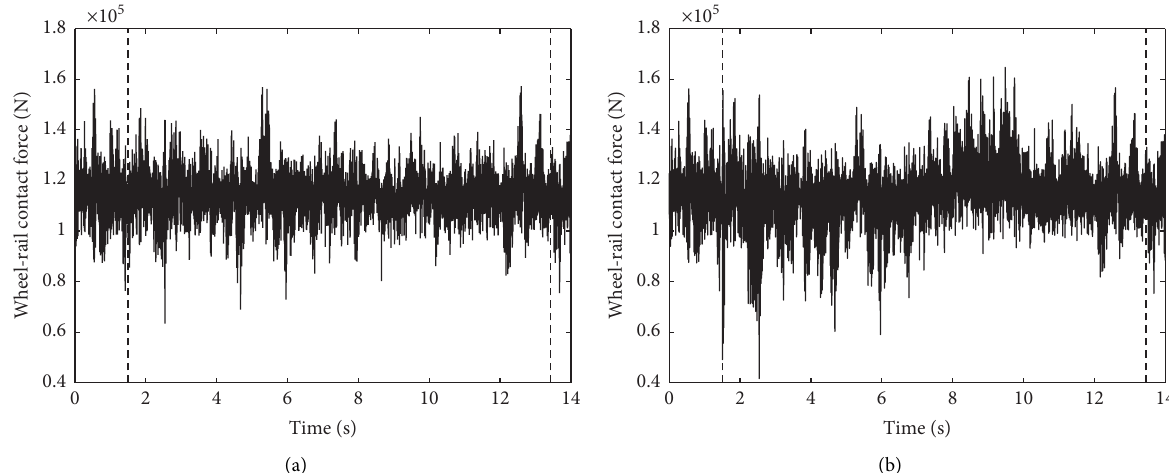
Figure 6: Effects of tunnel differential settlement on the wheel-rail contact force ( the moment when the train enters or leaves the settlement zone). (a) Without differential settlement. (b) With differential settlement.